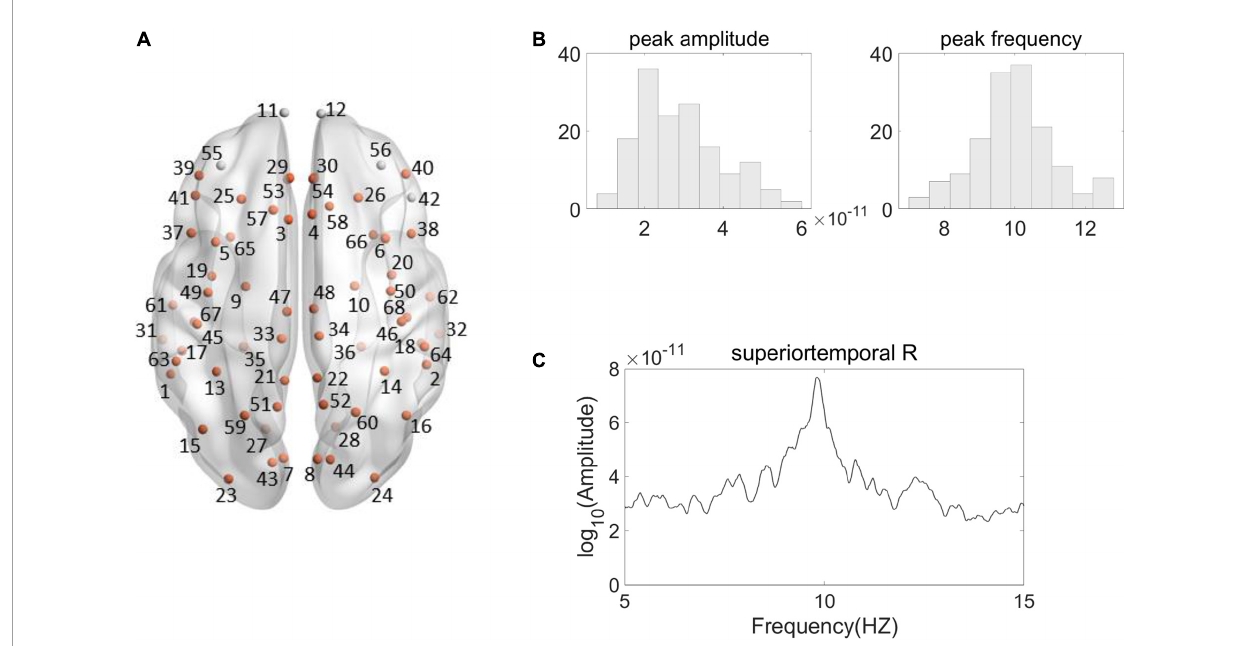
FIGURE2 Illustration of Alpha peak activity in the frequency spectrum. (A) Shown are the 68 Desikan–Killiany regions from a top view, among which the source regions showing valid alpha peak activity are indicated by the orange color. (The name and the number of the regions are according to the standard Desikan–Killiany atlas, see Supplementary Table 1 for further details). (B) Shown are the histogram distributions of individual alpha peak amplitudes (left) and frequencies (right) from a representative region (right superior temporal). (C) The spectrum of the representative region from a representative participant is shown. The source signal strength was under the sLORETA normalized unit.